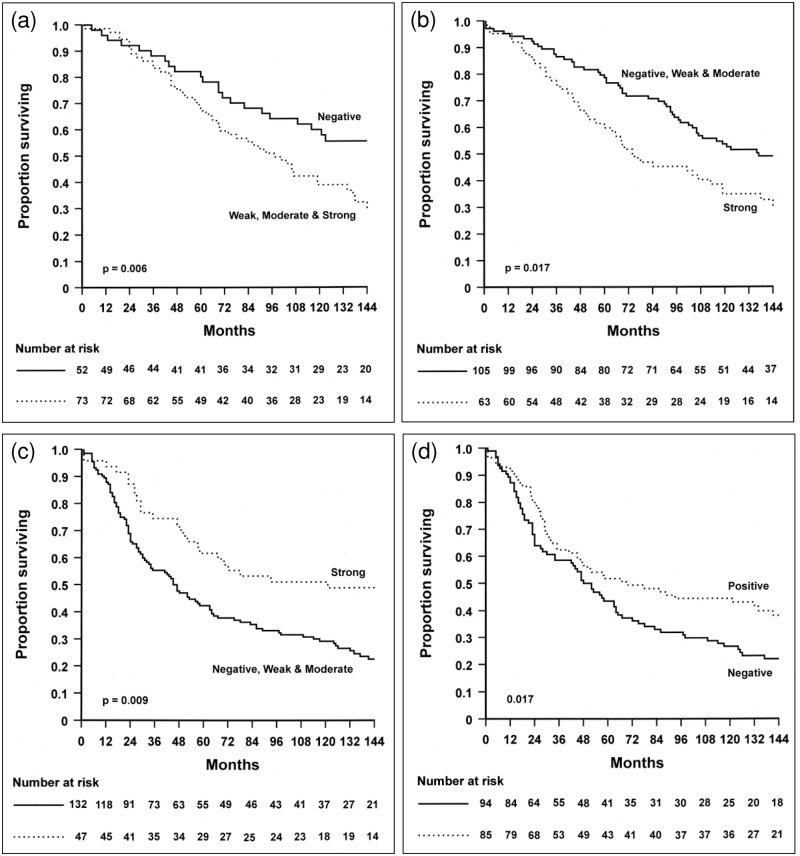
Kaplan-Meier overall survival analyses for uPARE (a and b), uPARS (c) and uPARPT (d) in rectal cancer.In stage B patients, (a): overall survival was significantly reduced with uPARE positive in central region of tumour (n = 125) and (b): with strong uPARE in invasive front of tumours (n = 168). In stage C patients, (c): strong uPARS in invasive front of tumour (n = 179) was significantly associated with longer overall survival. (d): Positive uPARPT in invasive front of tumour (n = 179) was also significantly associated with longer overall survival.